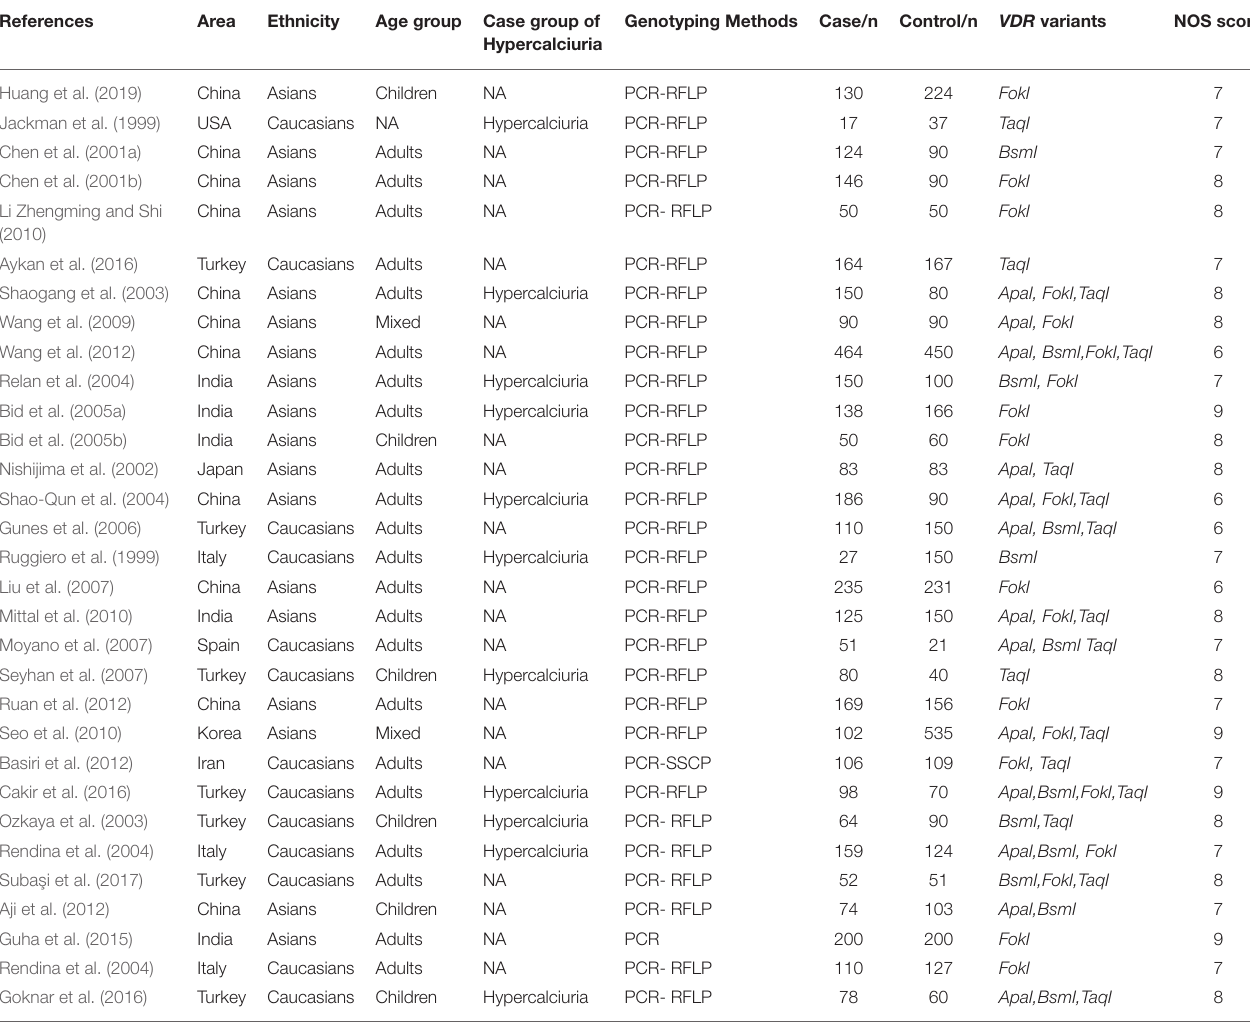
TABLE 2 | Main characteristics of recruited studies.